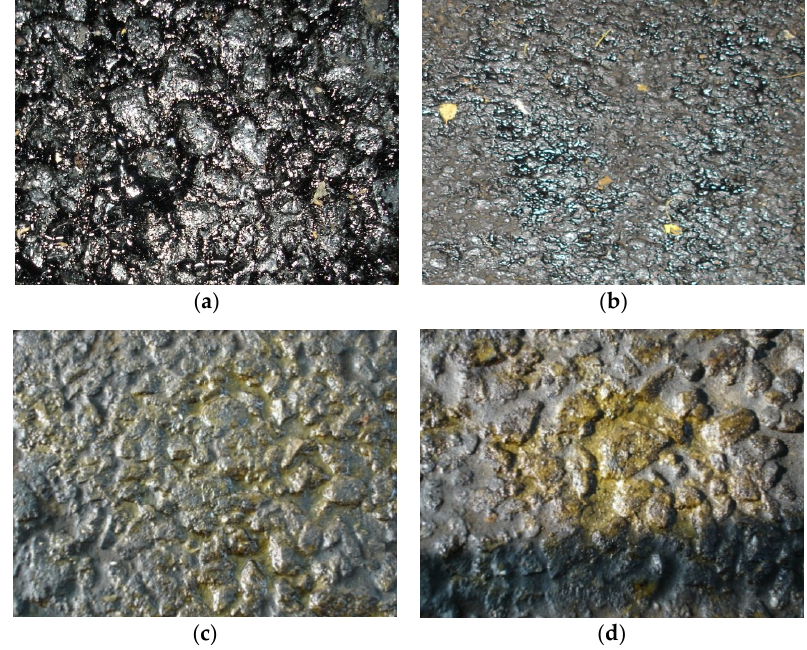
Figure 2. The comparison of the road spraying test. ( a ) Agent A (black and shiny); ( b ) Agent B (green and bleeding); ( c ) Agent D (yellowing and bleeding); ( d ) Agent E (yellowing and bleeding).